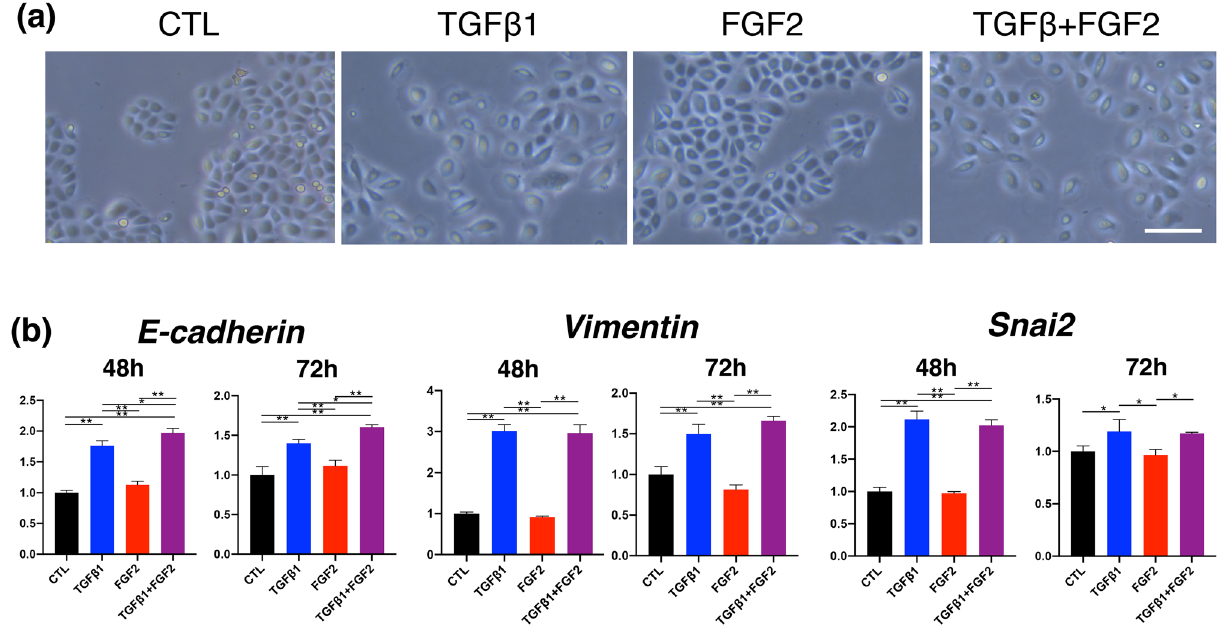
Figure 6. In vitro experiment using normal human epidermal keratinocytes (NHEKs) to compare among normal culture condition (CTL), TGFβ1 solo-stimulation, FGF2 solo-stimulation, and TGFβ1 and FGF2 co-stimulation (TGFβ1 + FGF2). ( a ) After 48 h of stimulation, NHEKs with TGFβ1 and TGFβ1 + FGF2 showed disseminated proliferation in contrast to the cobblestone pattern of those with normal medium and FGF2 treated condition. Scale bar: 20 μm ( b ) realtime RT-PCR analysis of NHEKs. The Y-axis represents the relative ratio normalized by CTL. mRNA expressions of E-cadherin, vimentin, and Snai2 at 48 and 72 h stimulation were highly and significantly upregulated in TGFβ1 and TGFβ1/FGF2. Solo treatment with FGF2 affected little in expressions of EMT-related transcription factors in NHEKs. Bar graphs are presented with the mean values ± standard error. * p < 0.05, ** p < 0.01, ANOVA with a post hoc Tukey